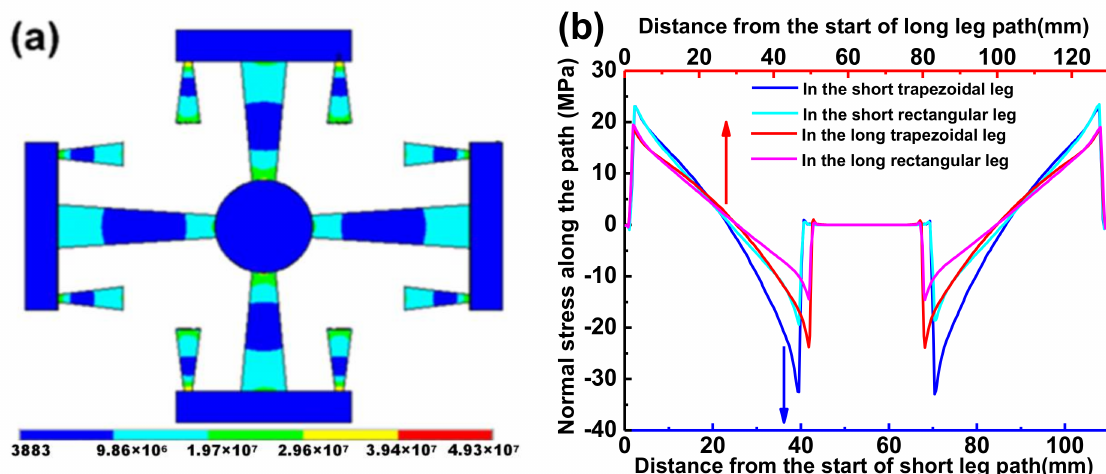
Figure 6. Stress distribution for Case 2: ( a ) von Mises stress and ( b ) normal stress along the leg paths.